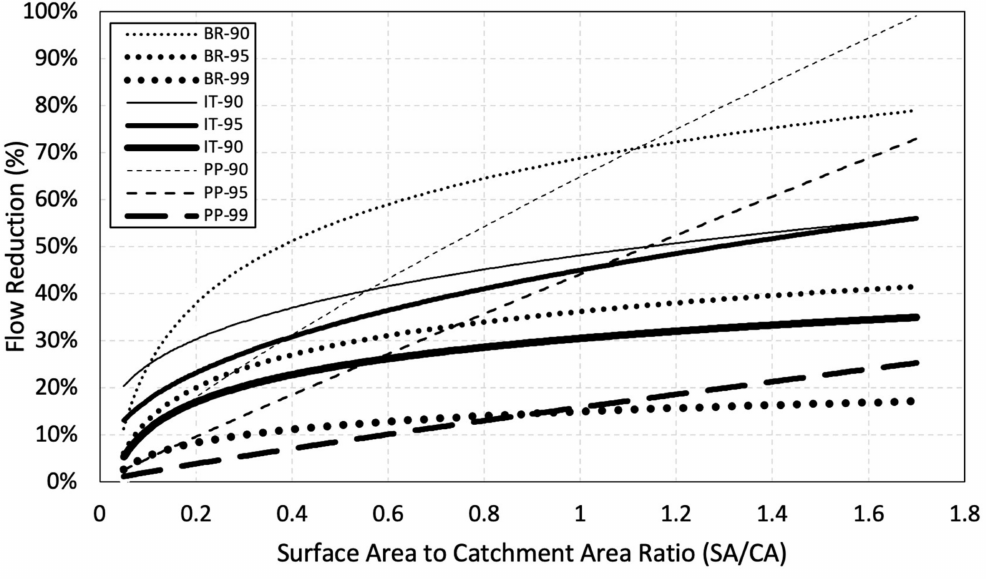
Figure 5. Regression analysis of the flow reduction of the bioretention (BR), infiltration trench (IT), and permeable pavement (PP) LID practices in the site area with respect to SA/CA ratio for the corresponding 90th, 95th, and 99th rainfall